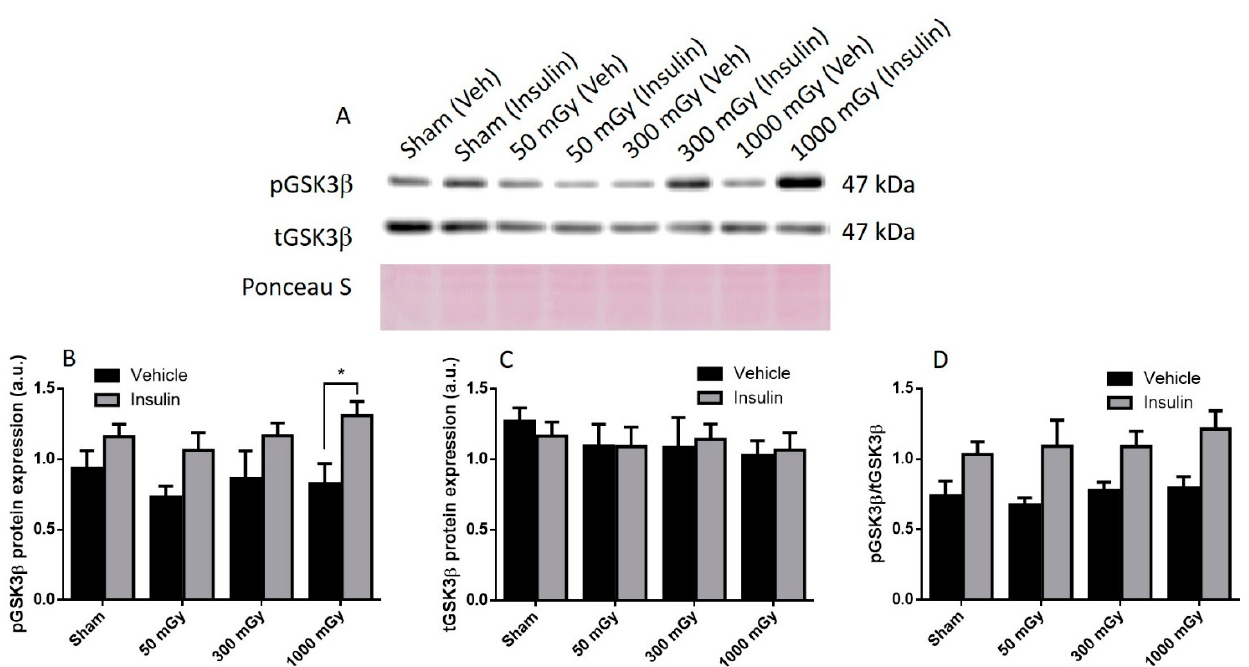
Antioxidants 2021 , 10 , x FOR PEER REVIEW 11 of 19 Figure 6. Representative western blot ( A ) and quantified band density (relative protein expression in arbitrary units) for phosphorylated GSK3 β (pGSK3 β ) ( B ), total GSK3 β (tGSK3 β ) ( C ), and the ratio of phosphorylated protein to total protein pared to Sham and 50 mGy groups, and the 1000 mGy group was significantly different ( D ) in hearts of female offspring. Results were normalized to loading controls (samples repeated on each gel) to account for differences between gels, and Ponceau S staining was used as a marker of equal protein loading. Data are presented as a mean ± SEM. *, denotes significantly different between vehicle and insulin injections, and p ≤ 0.05. n = 11–19 per group.